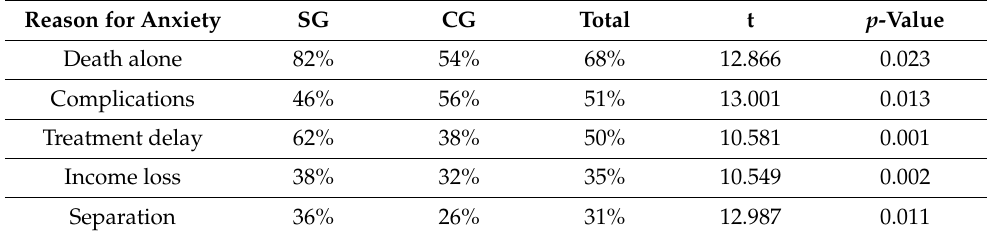
Table 4. The most frequently reported reasons for anxiety in the study group (N =